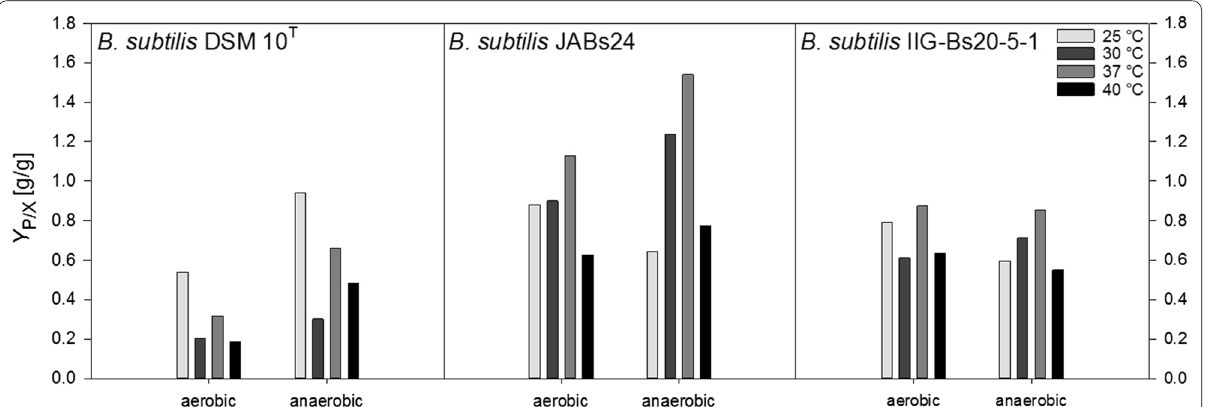
Fig. 6 Overview of the calculated product yields on biomass Y P/X (g/g) for strains B. subtilis DSM 10 T , B. subtilis JABs24 and B. subtilis IIG-Bs20-5-1 under aerobic and anaerobic conditions at 25 °C, 30 °C, 37 °C and 40